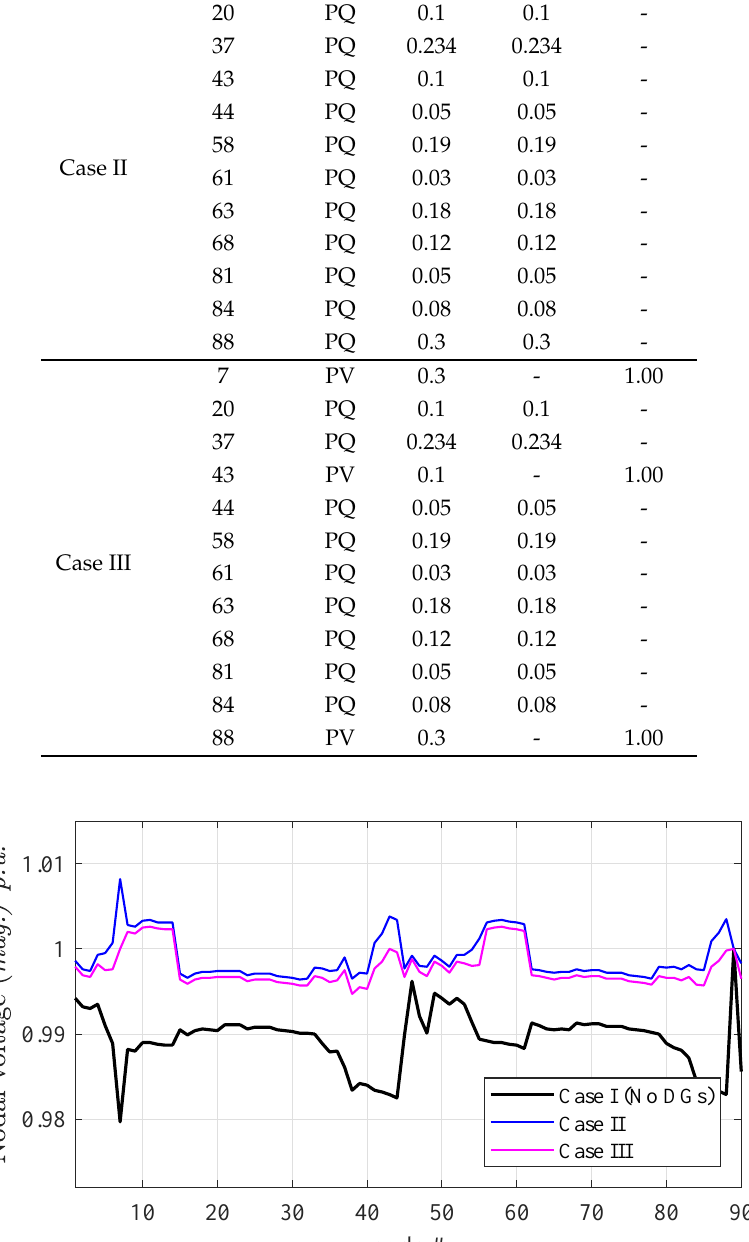
Figure 8. Voltage profile of the Test90 radial network; impact of generator sources (DGs) types and